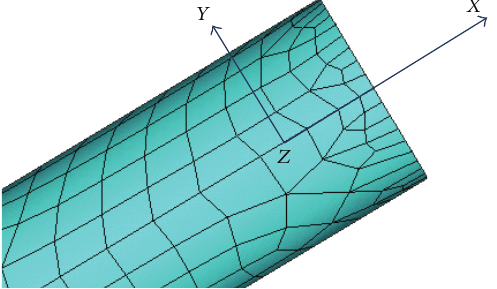
Figure 6: The unit coordinates of branch